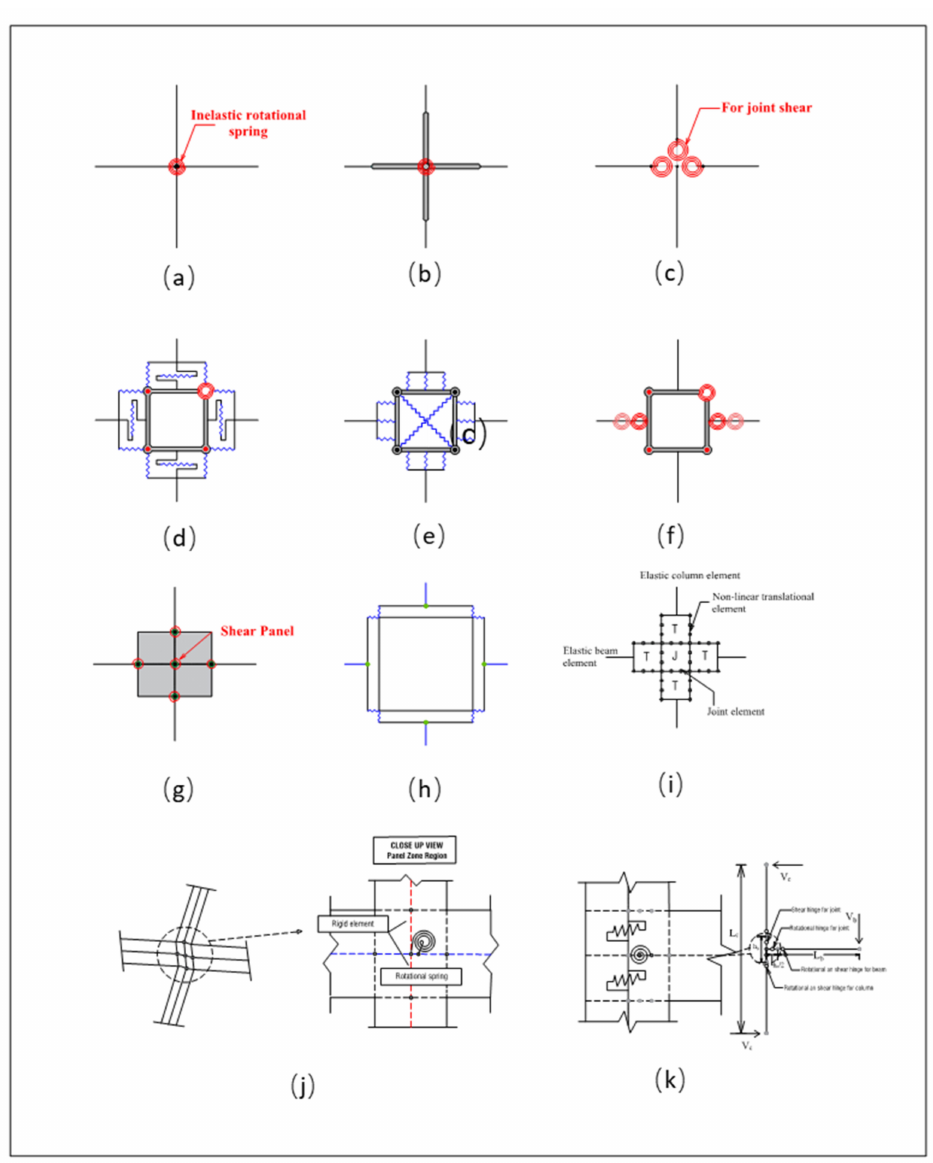
Figure 2. Existing simplified analytical models for the nonlinear modeling of reinforced concrete beam–column joint. ( a ) EI-Metawally and Chen (1988) [14]. ( b ) Alath and Kunnath (1995) [15]. ( c ) Biddah and Ghobarah (1999) [16]. ( d ) Lowes and Altoontash (2003) [17]. ( e ) Youssef and Ghobarah (2001) [18]. ( f ) Shin and LaFave (2004) [19]. ( g ) Altoontash (2004) [20]. ( h ) Ning et al. (2016) [21]. ( i ) Elmorsi et al. (2000) [22]. ( j ) Pampanin et al. (2003) [23]. ( k ) Sharma et al. (2011)